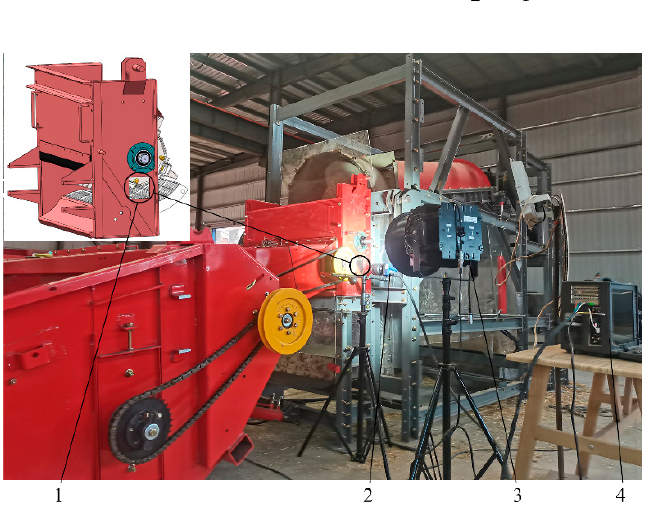
Figure 4. Conveying performance experiment site. 1. Observation window; 2. High-speed digital camera; 3. Light source; 4. Computer.